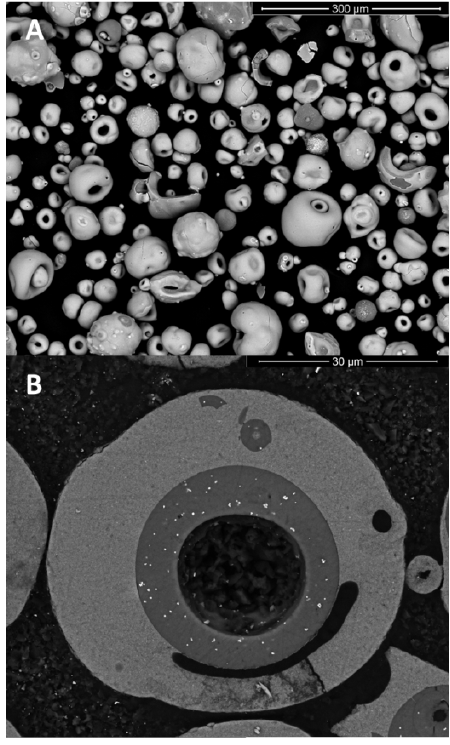
Figure 1. SEM images from Magnox photocatalyst: ( A ) general view of the particles; ( B ) sectioned and polished particle showing the silica (dark layer surrounding the central pore), magnetite (brightest points inside silica layer), and titanium oxide (the grey layer around silica layer).